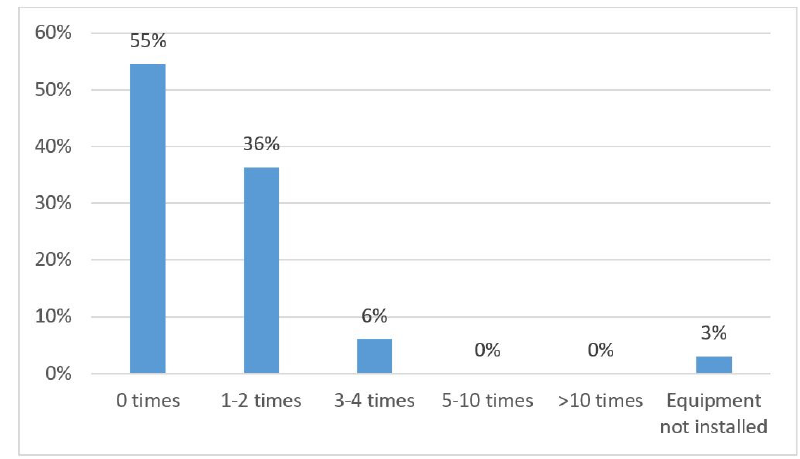
Figure 8. Frequency of use of the INMARSAT-C ship Earth station (SES).